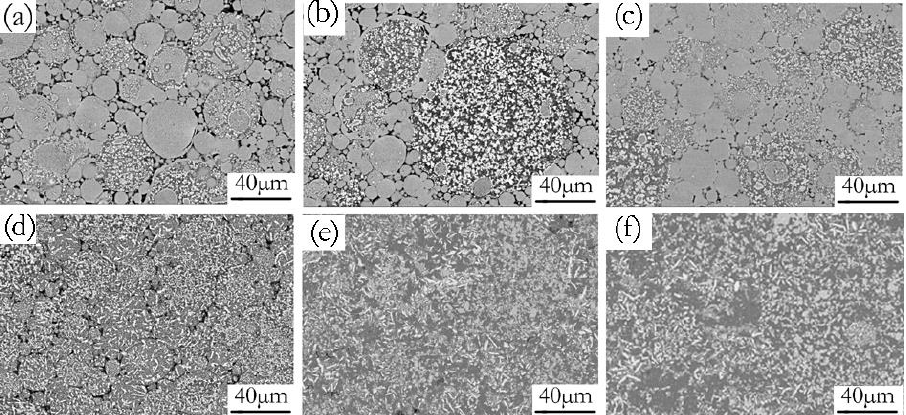
Figure 10. SEM / BSE micrographs of green ( a – c ) and sintered ( d – f ) samples under the di ff erent Figure 10. SEM/BSE micrographs of green ( a – c ) and sintered ( d – f ) samples under the different compaction velocities (a,d) 6.2 ms − 1 , (b,e) 7.9 ms − 1 , (c,f) 9.4 ms − 1 compaction velocities (a,d) 6.2 ms − 1 , (b,e) 7.9 ms − 1 , (c,f) 9.4 ms − 1.